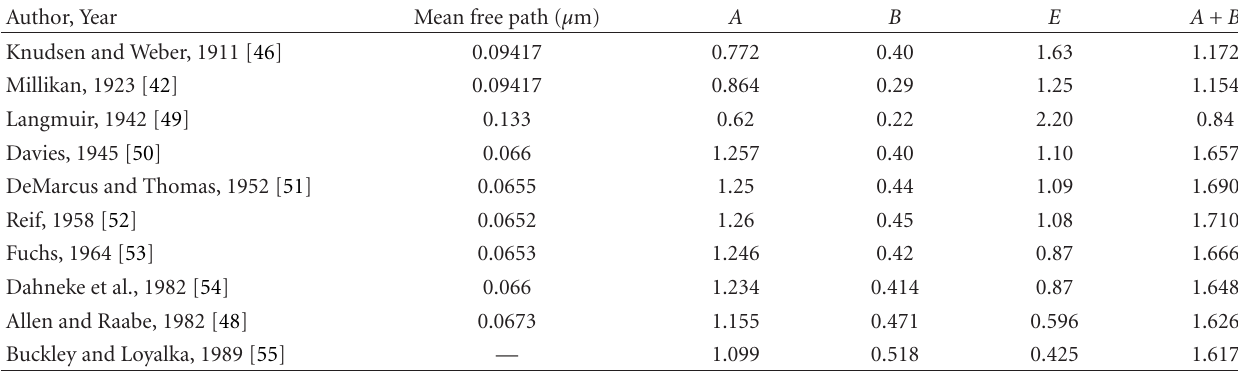
Table 2: Stokes-Cunningham slip correction factors, reprinted from Li and Wang [41] http://link.aps.org/doi/10.1103/PhysRevE.68.061206, and Allen and Raabe [48], Copyright 2003 and 1982, with permission from American Physical Society and Elsevier, respectively.